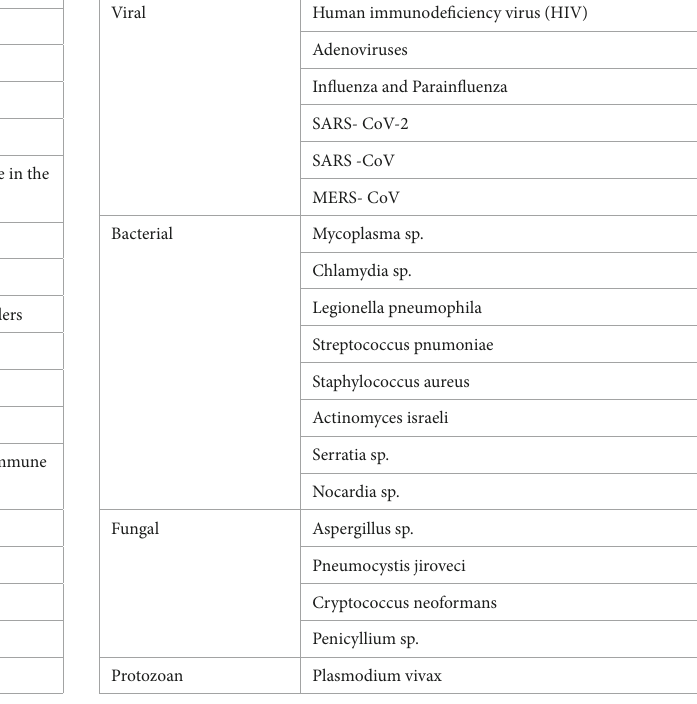
TABLE 2 Infectious factors which can induce